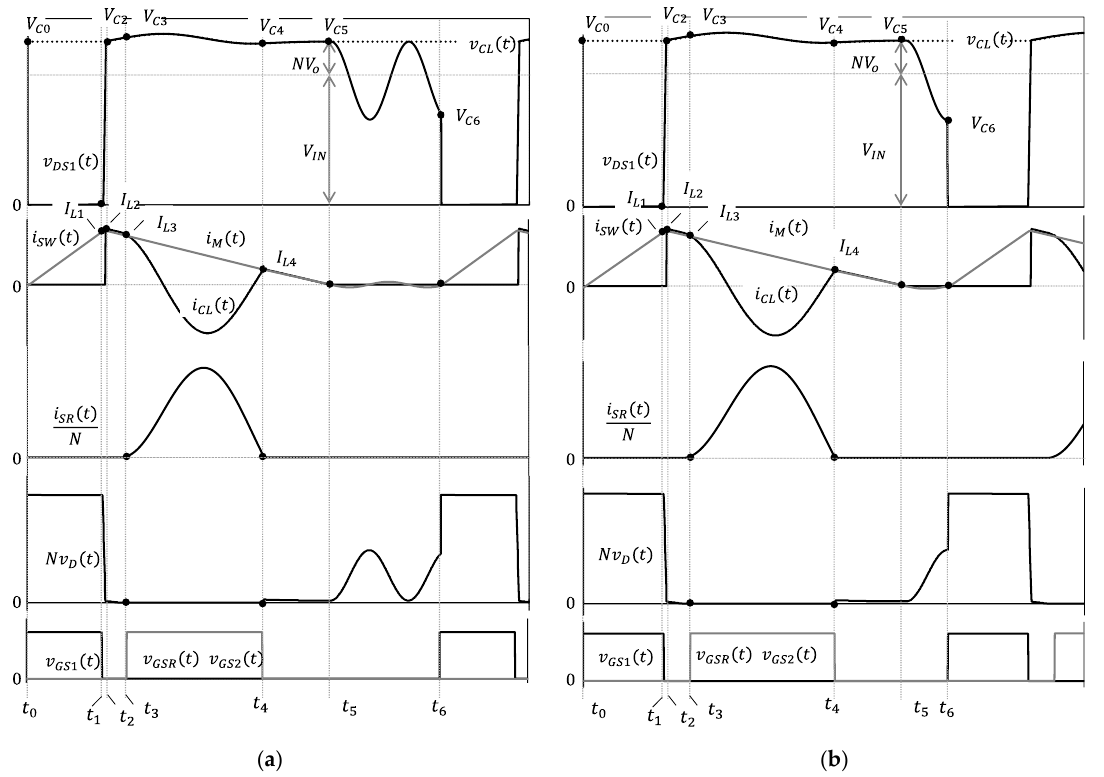
Figure 5. Steady-state operating waveform of QR flyback converter with SDAS: ( a ) steady-state operating waveform of a QR flyback converter with two valley voltages; ( b ) steady-state operating waveform of a QR flyback converter with one valley voltage.